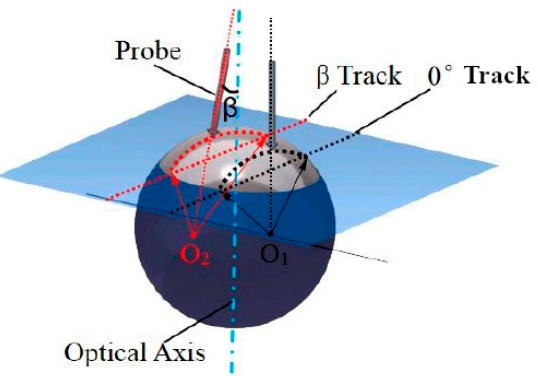
Figure 4. Three-dimensional relationship between spherical lens and stylus with different inclination angles.